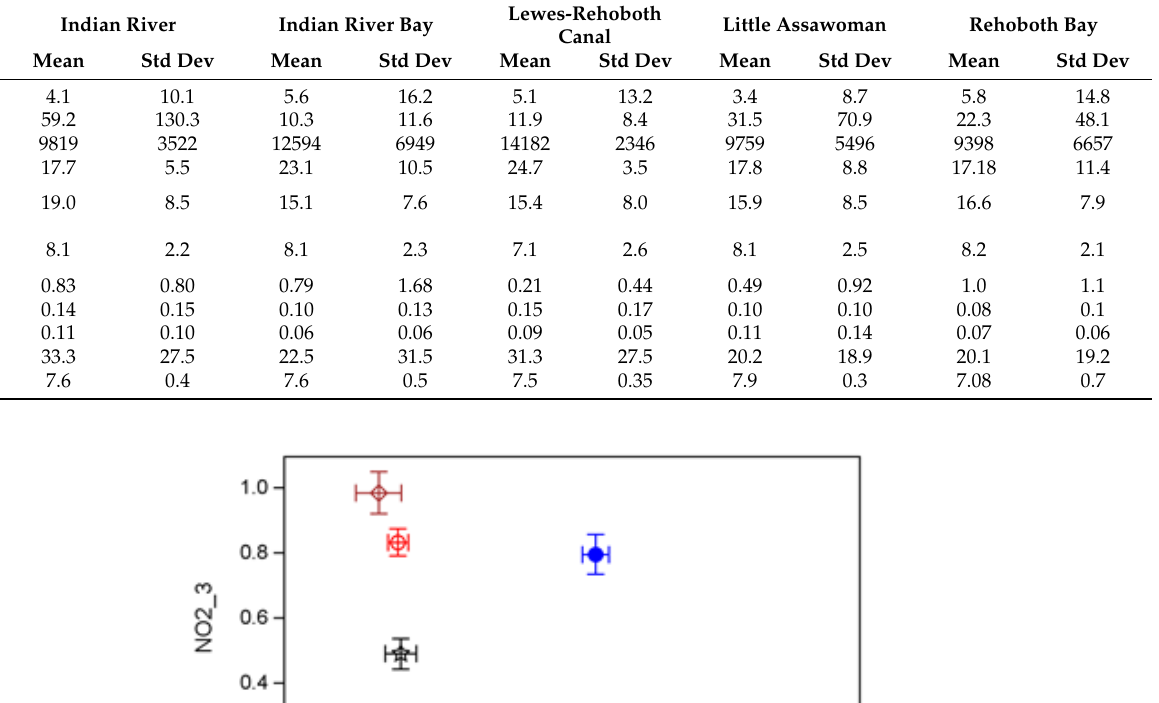
Table 2. Summary statistics for all five watersheds. Units of measurement were inches for Secchi depth; ppt for salinity; degree C for temperature; mg/L for dissolved oxygen, nitrite+nitrate, ammonia-N, phosphate-P, total suspended solids, chloride; and µ g/L for Chlorophyll-a.